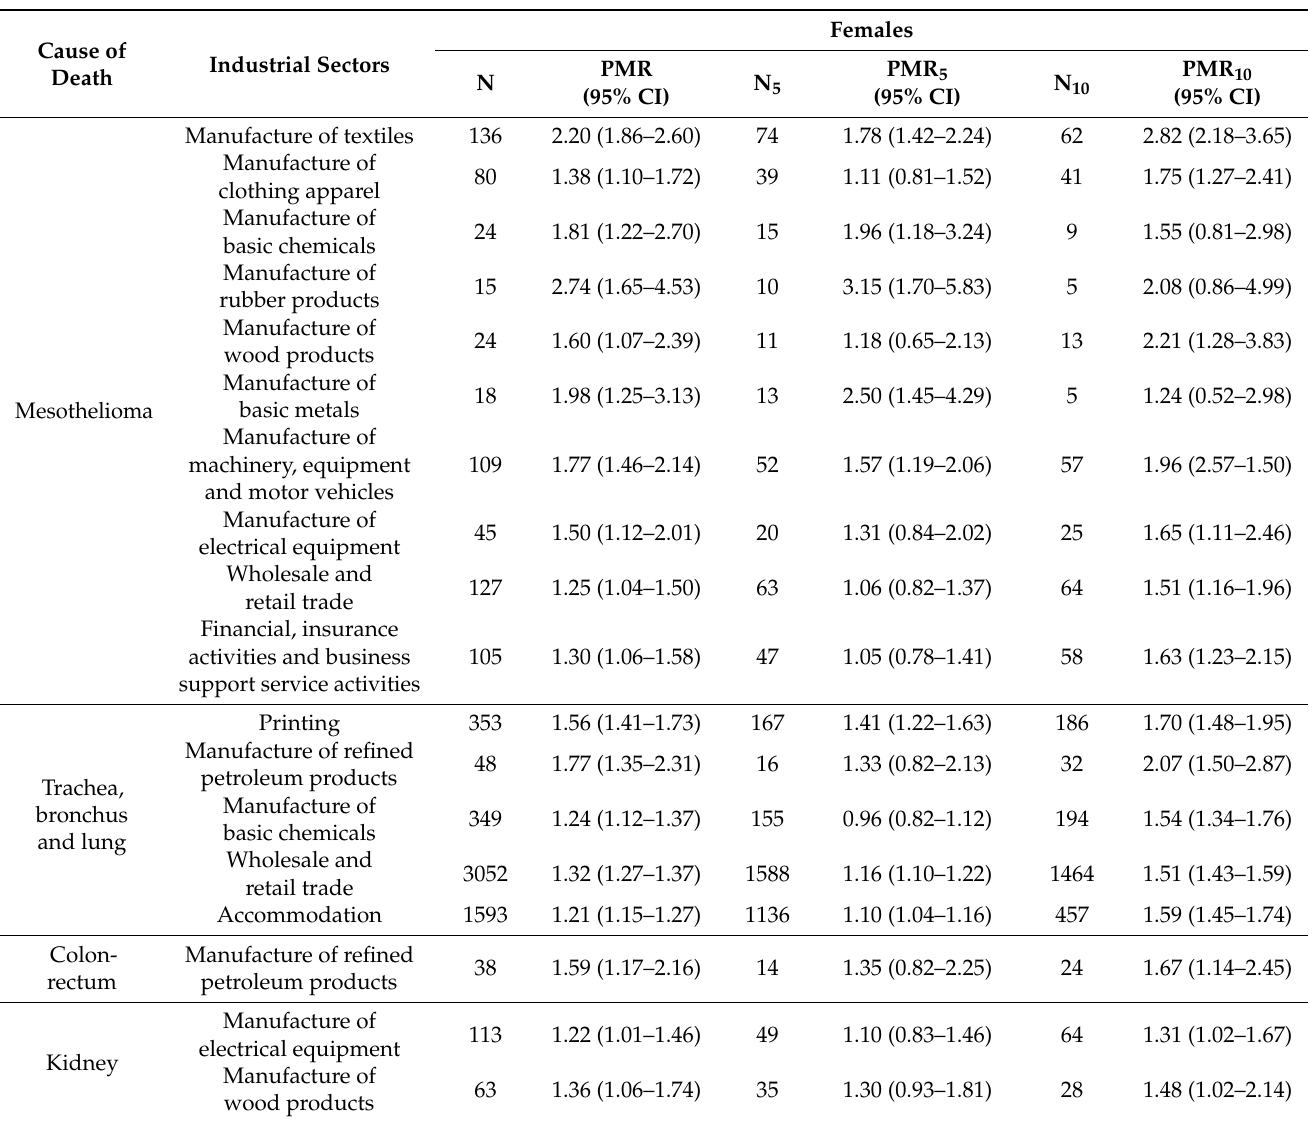
Table 3. Occupational Mortality Matrix (OMM) based on proportional mortality ratios (PMRs) by cause of death and industrial sector (*) for